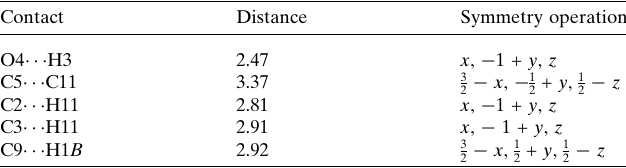
Table 2 Summary of short interatomic contacts (A˚ ) in